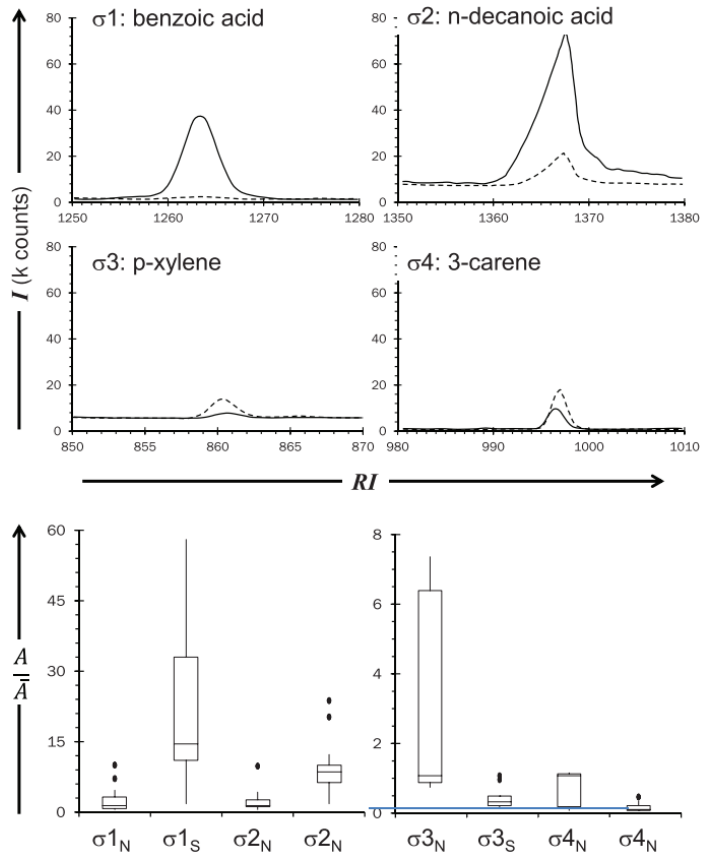
Figure 4. Overlaid extracted ion chromatograms from a sample from the four stress VOCs. Reproduced from Martin et al. [53]. Table 1. Released amount of volatile organic component (VOC) stress biomarkers. Reproduced from Tsukuda et al. [19]. AUC, area under the curve.